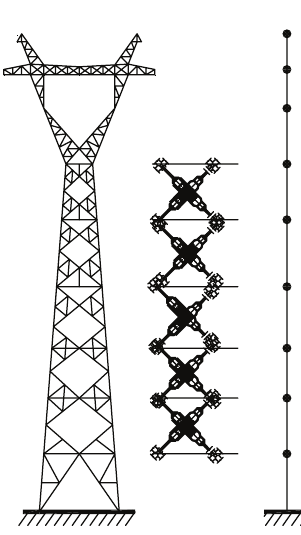
Figure 15: Installation scheme of energy-dissipating dampers on transmission